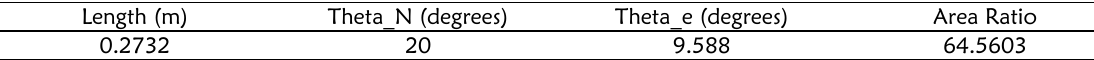
Table 2: Design parameters for the dual-bell nozzle